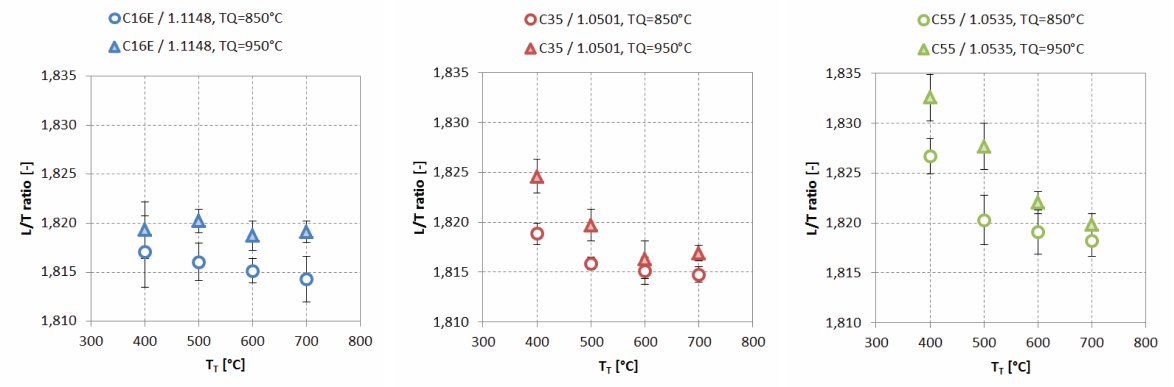
Figure 3. Measured L/T ratio values grouped by steel type. C16E (blue), C35 (red) and C55 (green). Values for quenching temperatures T Q = 850 °C (circle) tend to be in all cases lower than for T Q = 950 °C